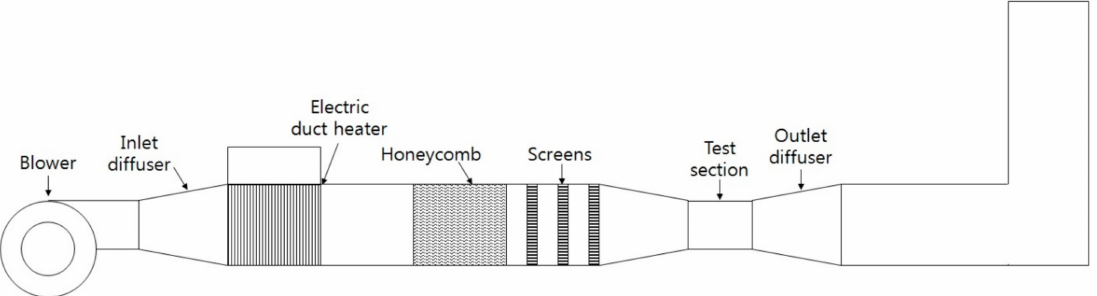
Figure 5. Schematic diagram of comprehensive test system of